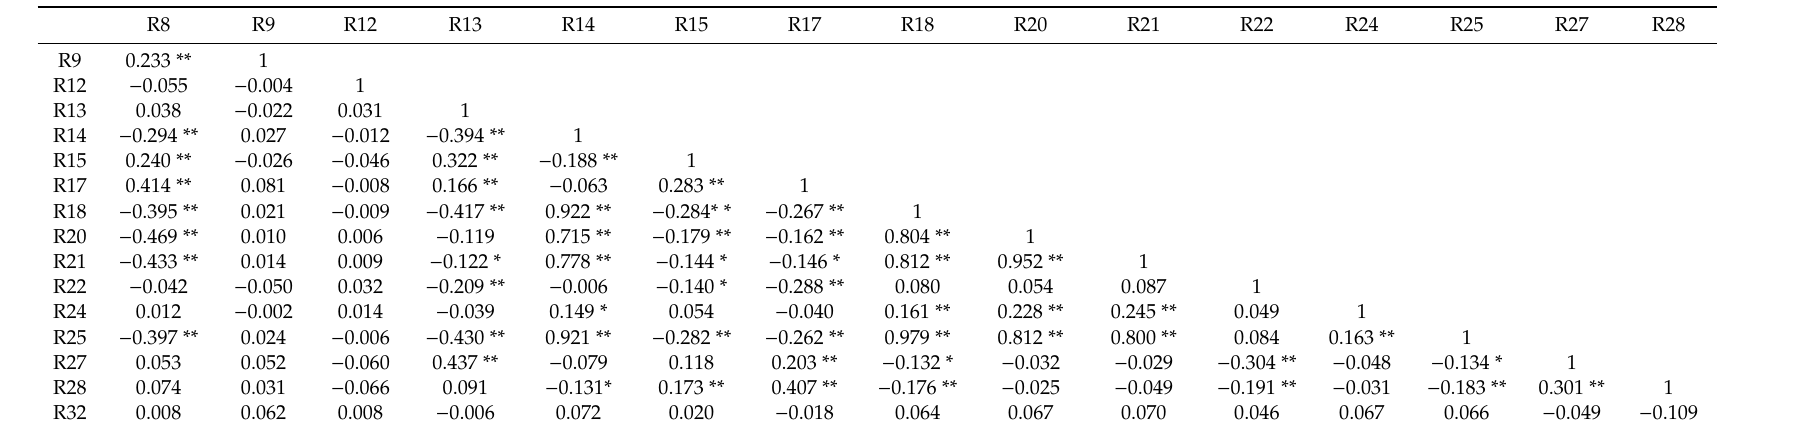
Table 4. Pearson correlation